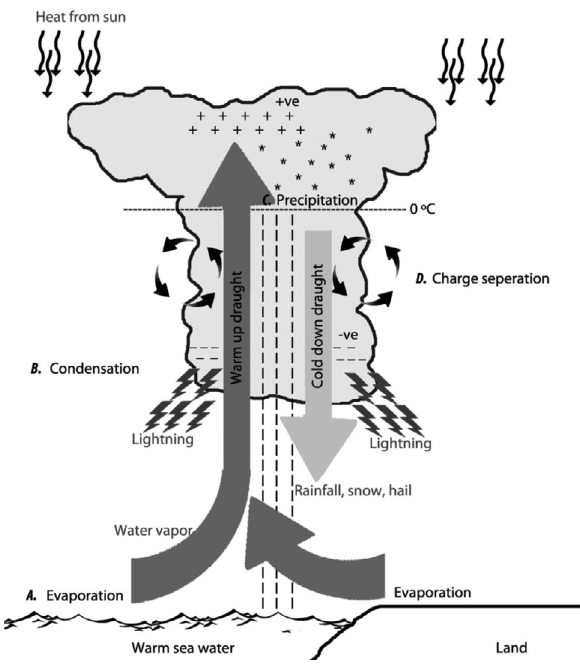
Figure 12. The water evolution and the process involved. The mechanism process started from the evaporation (labeled as A ) until charge separation (labeled as D